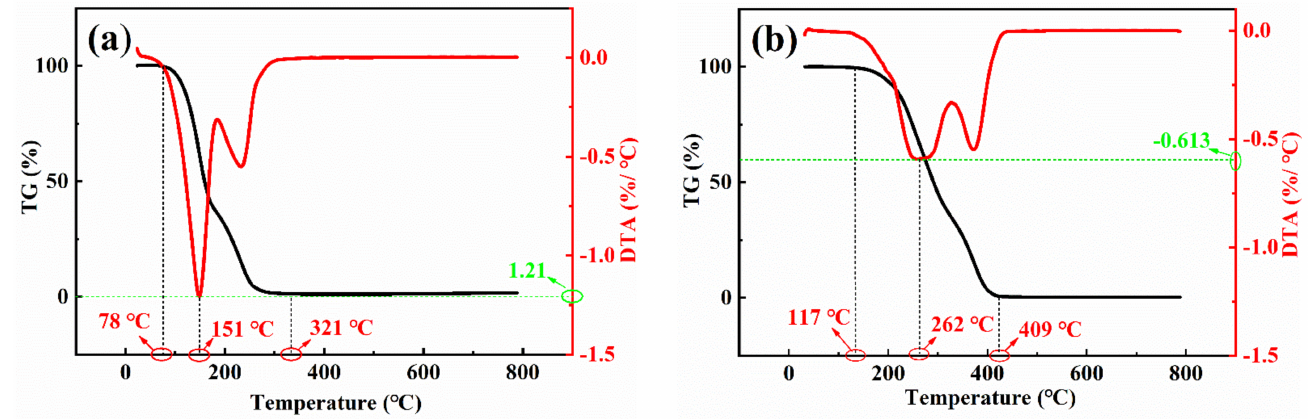
Figure 12. TGA curve and DTG curve of ( a ) PCM and ( b )